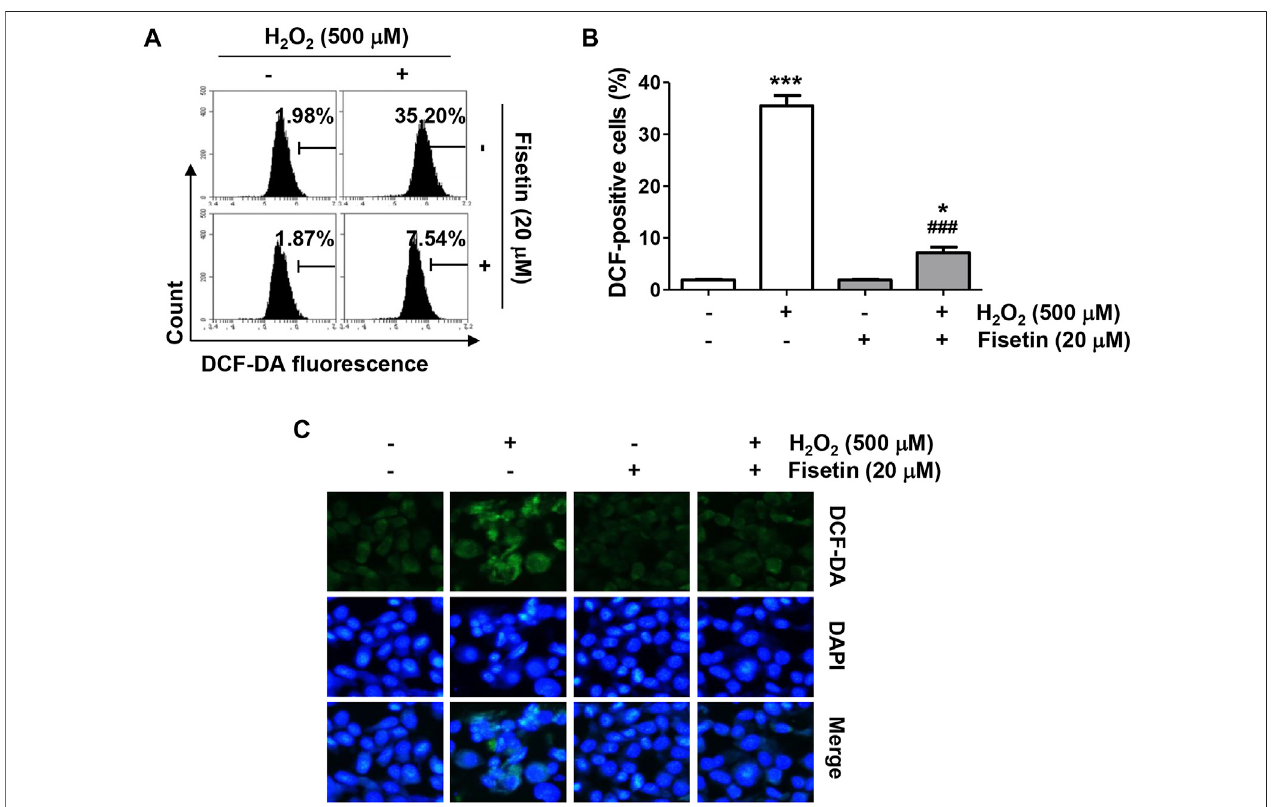
FIGURE2| FisetinattenuatedH 2 O 2 -inducedintracellularROSgenerationinARPE-19cells.Cellsweretreatedwithorwithout20 μ M fi setinfor1 handthentreated with 500 μ M H 2 O 2 for 1 h. The levels of ROS production were determined using DCF-DA dye. (A) Representative results from fl ow cytometry analyses are shown. (B) The values of fl ow cytometry results are expressed as mean ± SD ( n = 3, * p ˂ 0.05, and *** p ˂ 0.001 compared with the control group; ### p ˂ 0.001 compared with H 2 O 2 treatment group). (C) The level of ROS (green) was observed under a fl uorescence microscope, and representative images are presented. Nuclei were counterstained with DAPI (blue). Pretreatment of fi setin signi fi cantly suppressed increment of DCF-positive cell population following H 2 O 2 .